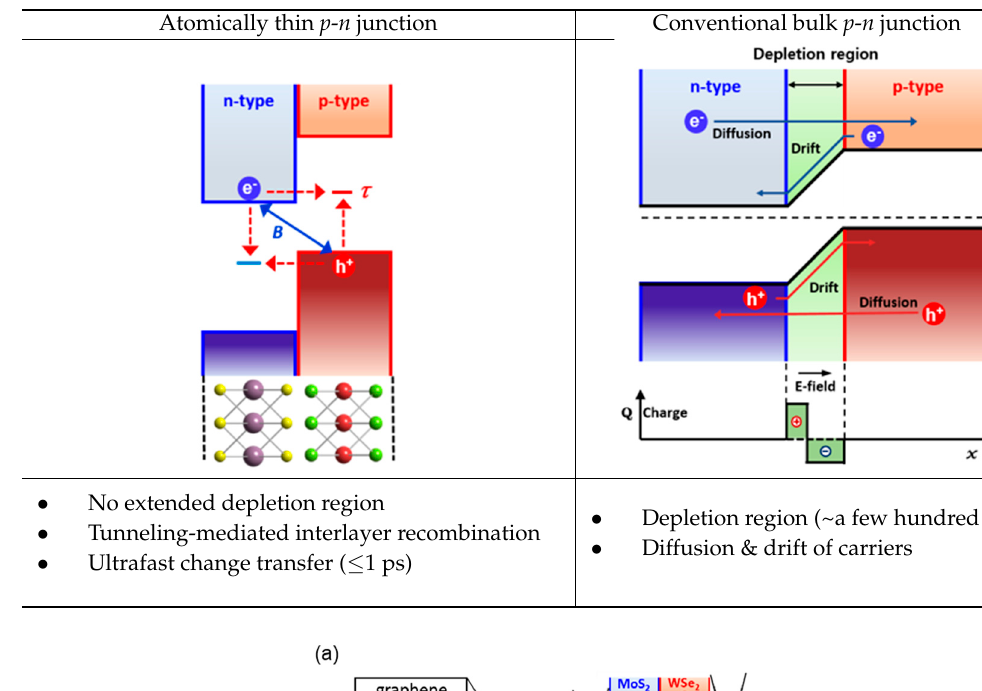
Table 2. Comparison between the atomically thin p ‐ n junction and the conventional bulk p ‐ n junction.